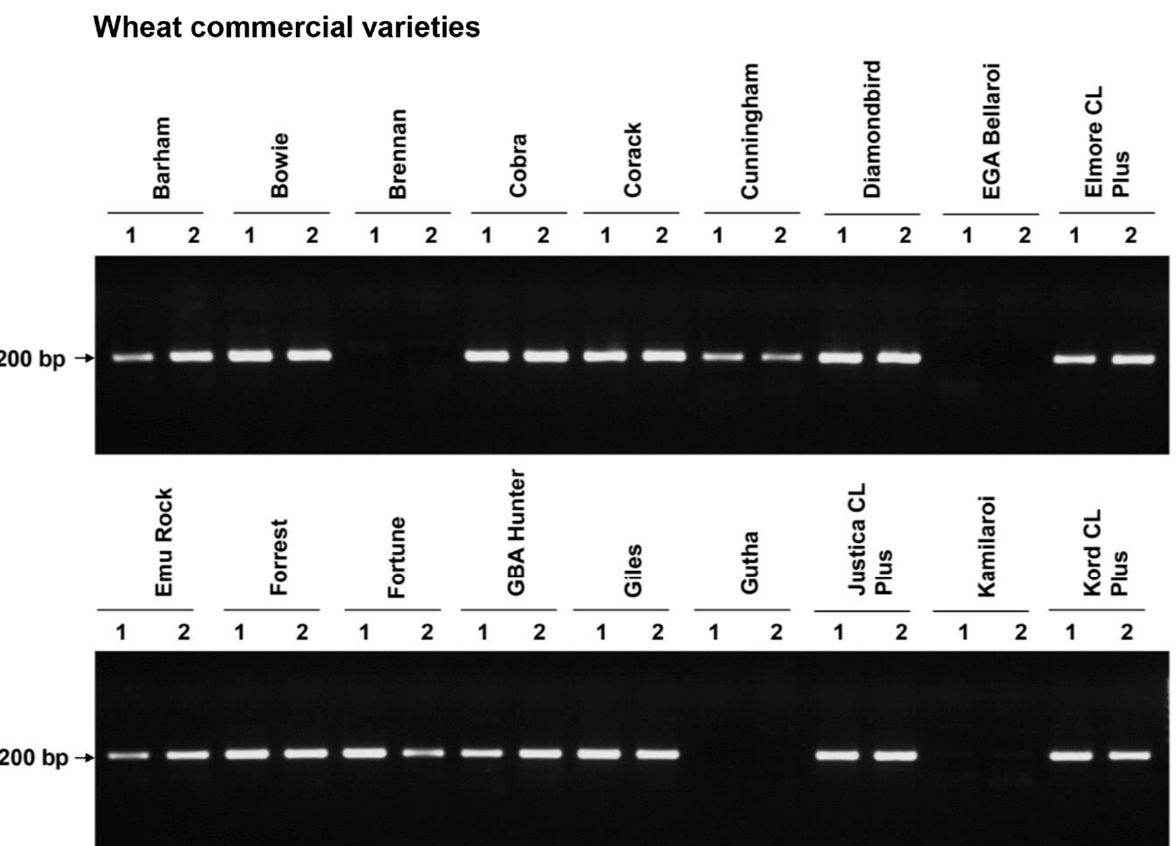
Figure 1. PCR-based detection of the Ta 1AS3422 marker. Example of presence or absence of Ta 1AS3422 marker in various commercial bread wheat (hexaploid) and durum (tetraploid) varieties analysed via agarose gel electrophoresis. For each variety, the PCR assay was performed on two DNA samples extracted from two independent seedlings (1 and 2).